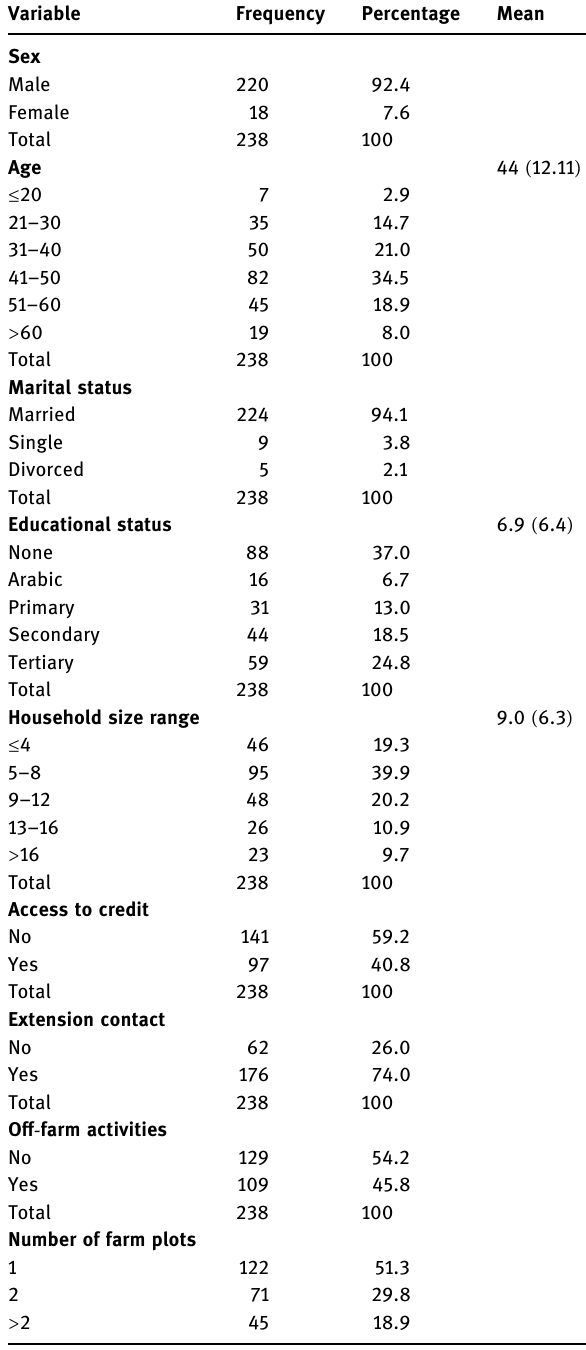
Table 2: Distribution of respondents by their socioeconomic